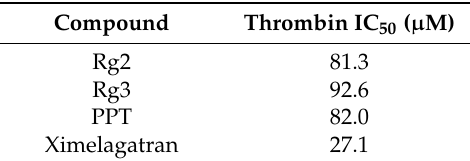
Table 2. Selectivity versus thrombin.